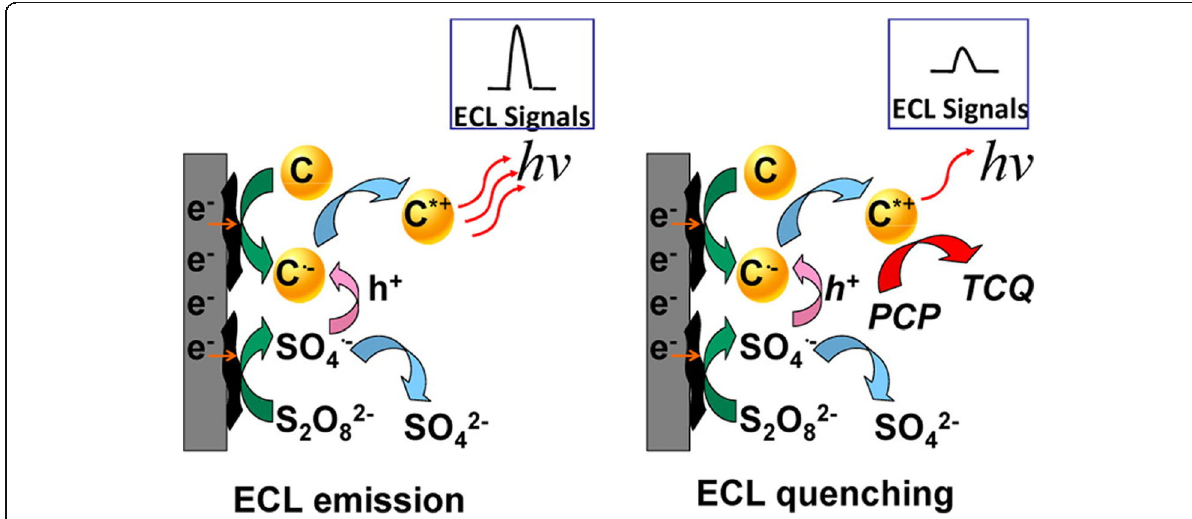
Fig. 18 Illustrative ECL detection mechanism for PCP with CQD/GR in S 2 O 82 − solution (reprinted with permission from Reference Yang et al. 2013). © 2013 American Chemical